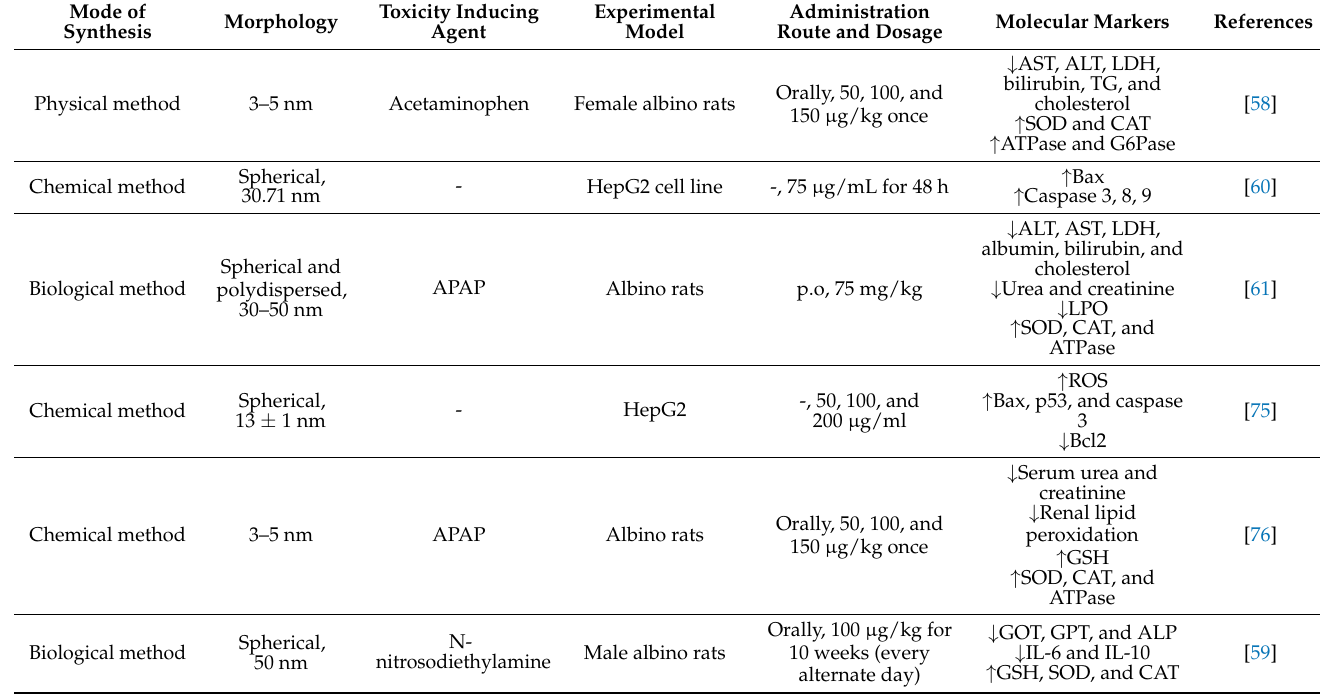
Table 1. Summary of the ameliorative effects of AgNPs against hepato-renal